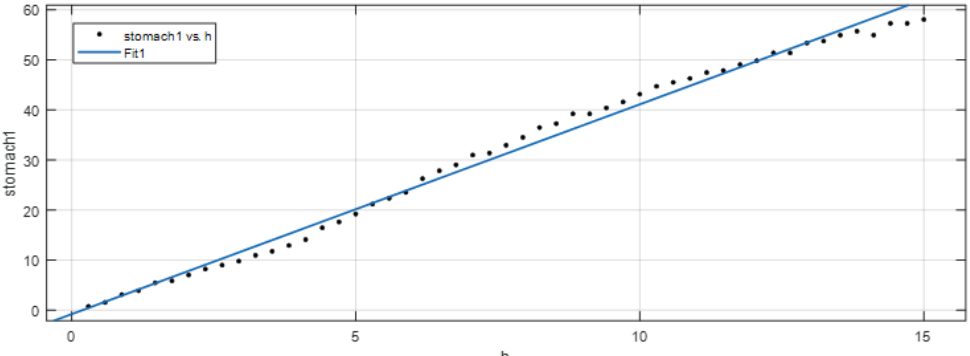
Figure 19. Fitting of the values of the portion of the graph highlighted by the green rectangle with the polynomial